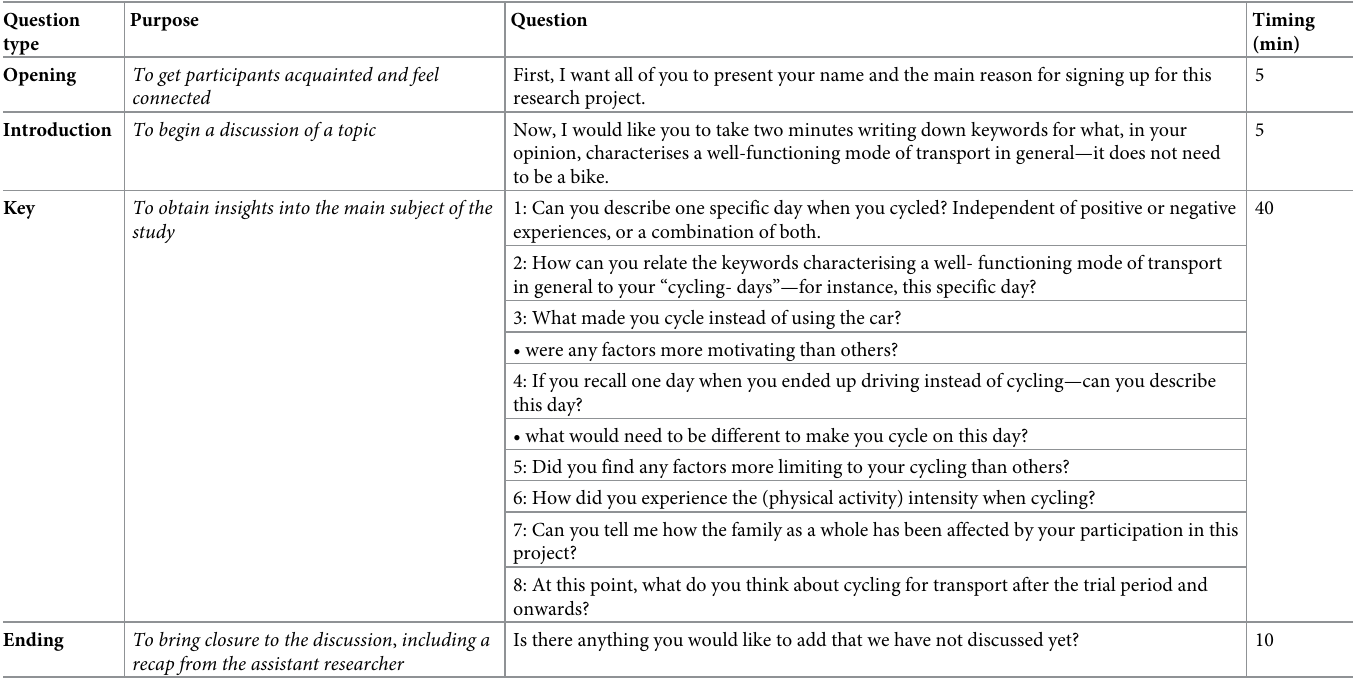
Table 2. Semistructured discussion guide for the focus group